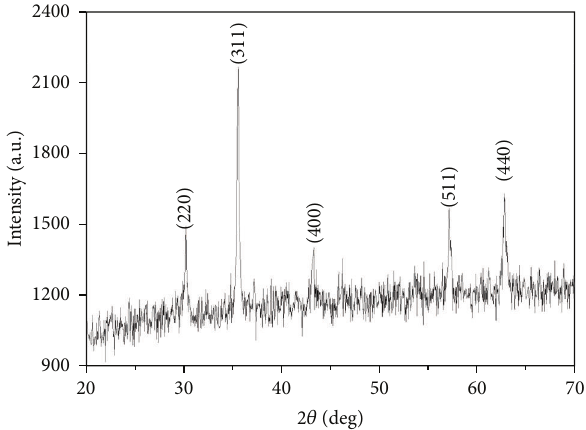
Figure 2: X-ray diffraction spectra of CoFe 2 O 4 (without external calcination) at room